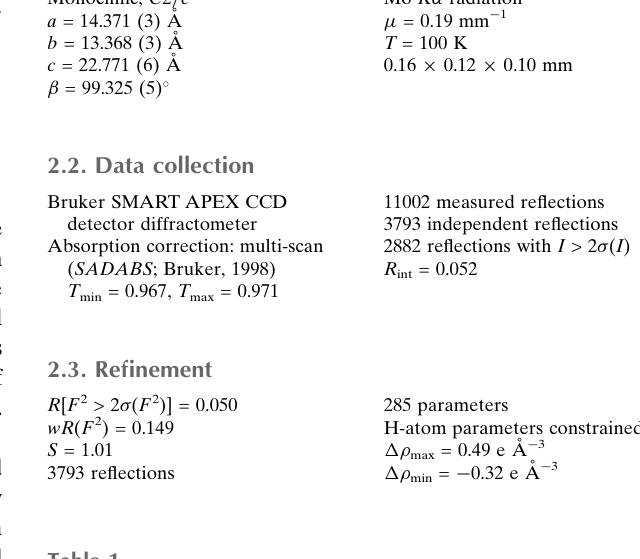
Hydrogen-bond geometry (A˚ , (cid:2)